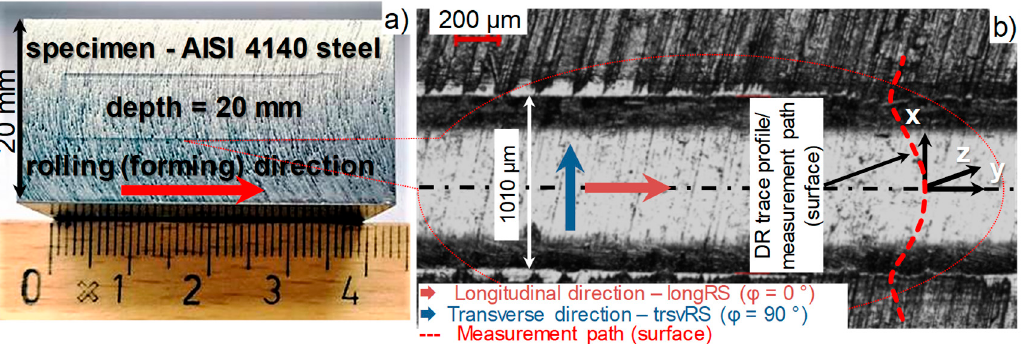
Figure 2. ( a ) Specimen’s geometry and material; ( b ) microscope image of the DR trace and measurement directions.